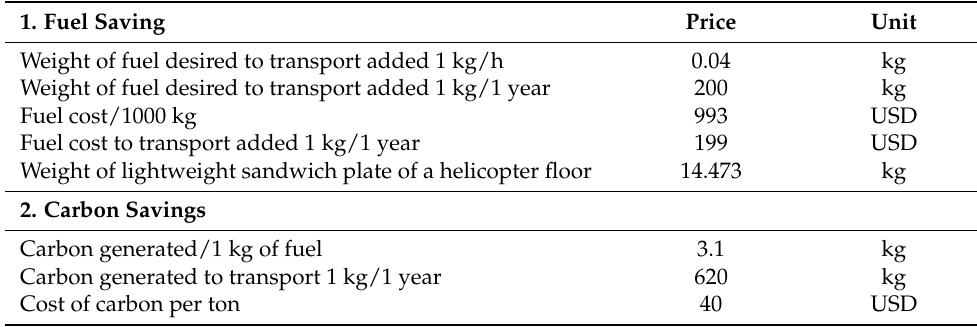
Table 8. Annual fuel and carbon savings of the sandwich plate for 1